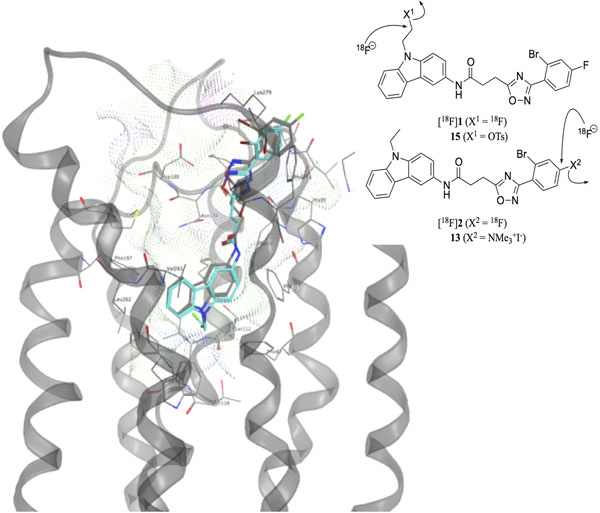
Compounds 1 and 2 fitted into the binding pocket of the CB2R receptor model.